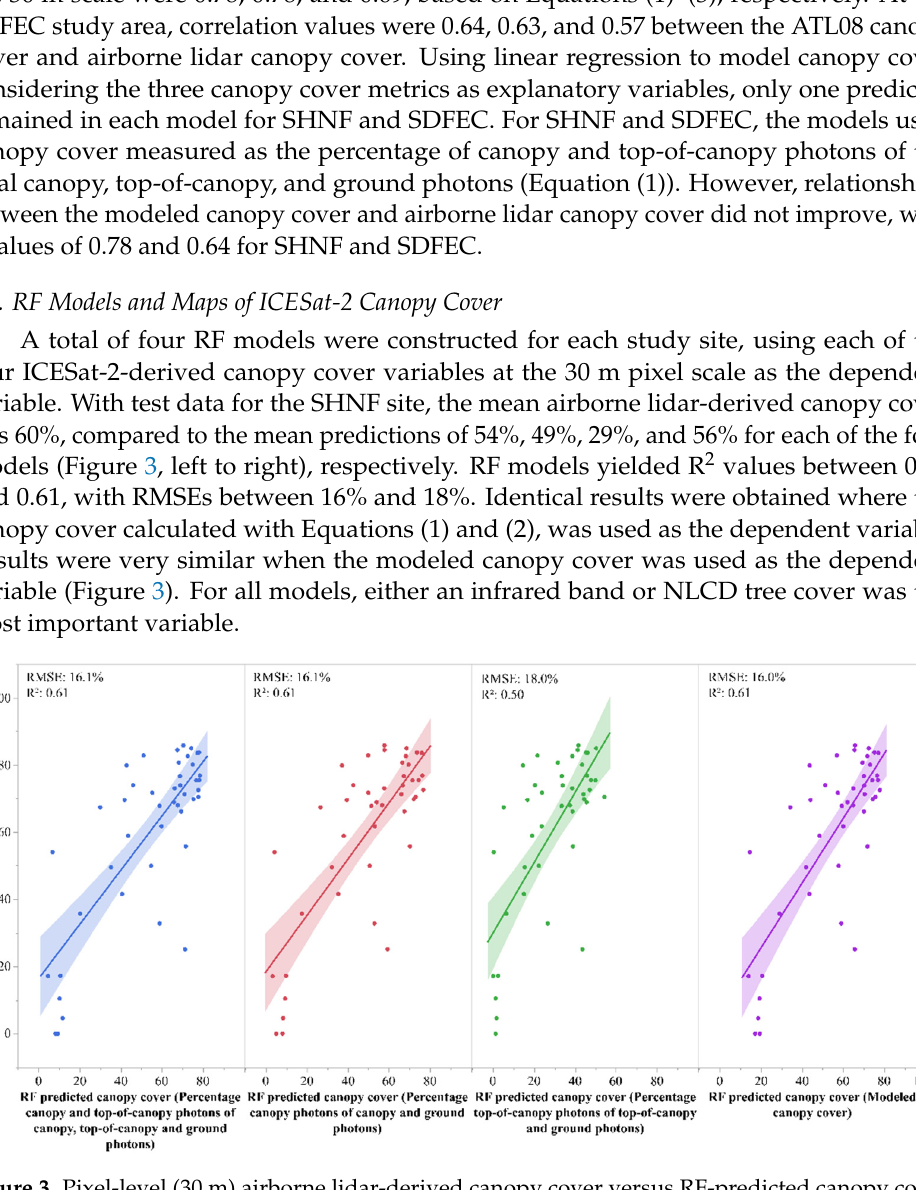
Figure 3. Pixel-level (30 m) airborne lidar-derived canopy cover versus RF-predicted canopy cover for